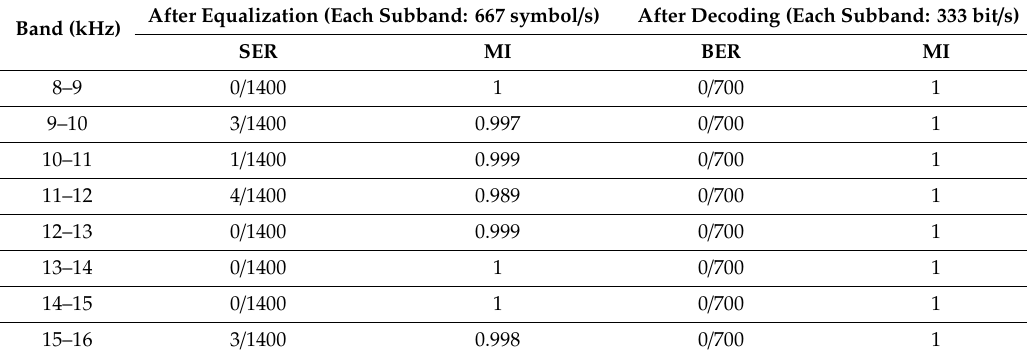
Table 2. Results of the proposed method with BPSK mapping.